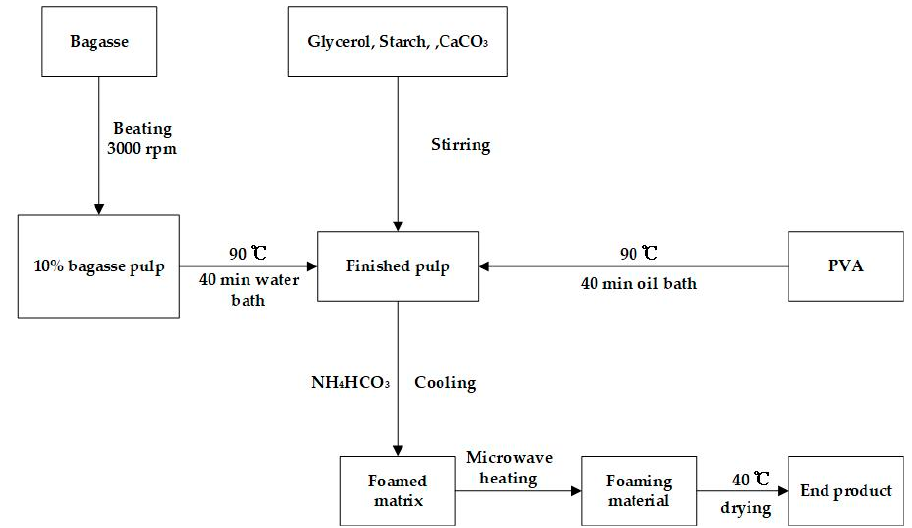
Figure 1. Foaming process diagram.